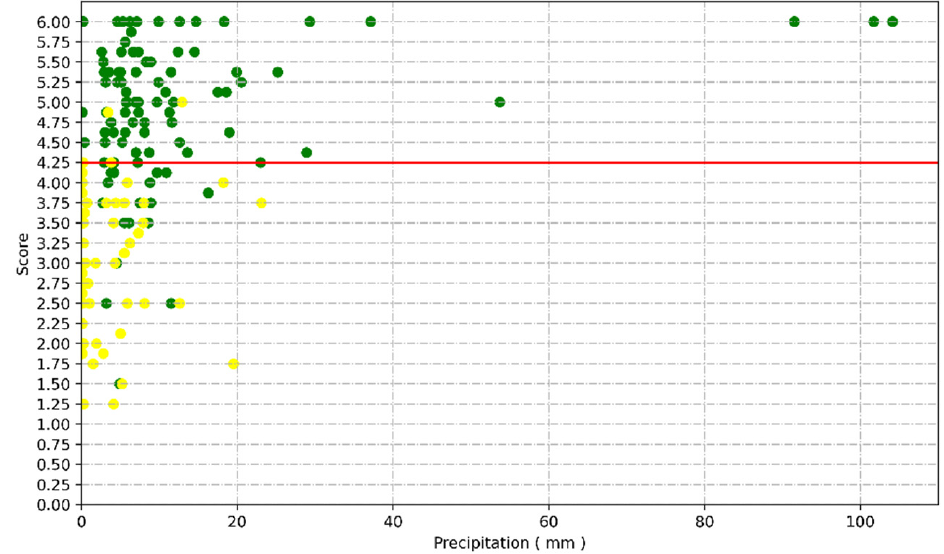
Figure 10. July–September 2021 suspicious precipitation and scoring values for Hainan Province (yellow dots are incorrect suspicious precipitation, green dots are correct suspicious precipitation, and the red line is the 4.25 threshold).